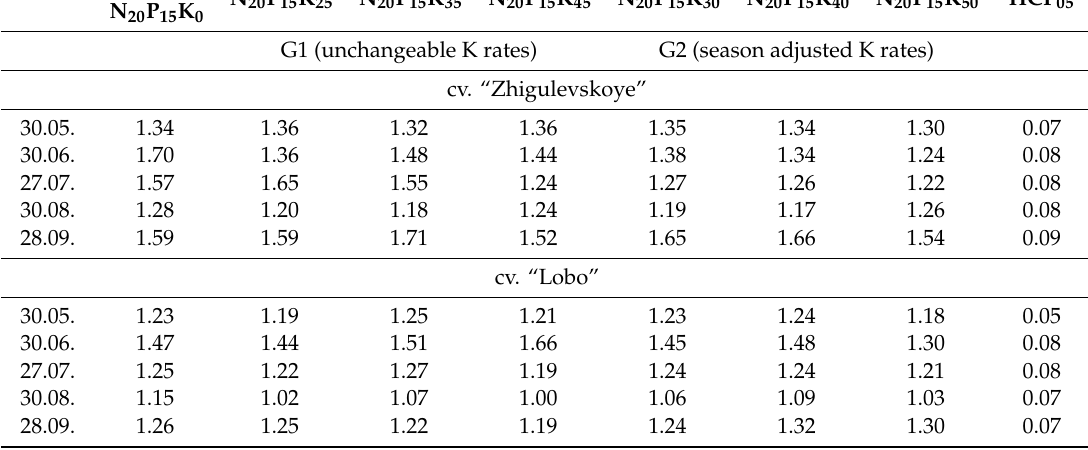
Table 14. Seasonal changes of the calcium leaf status under the influence of di ff erent potassium fertilization rates and fertigation approaches in 2017, %